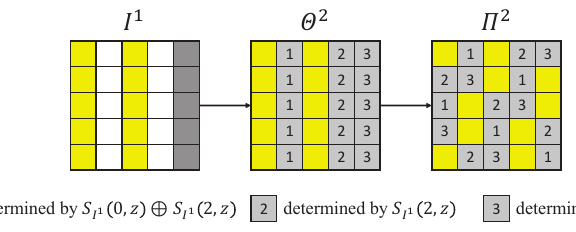
The relation between column sums and constant bits.